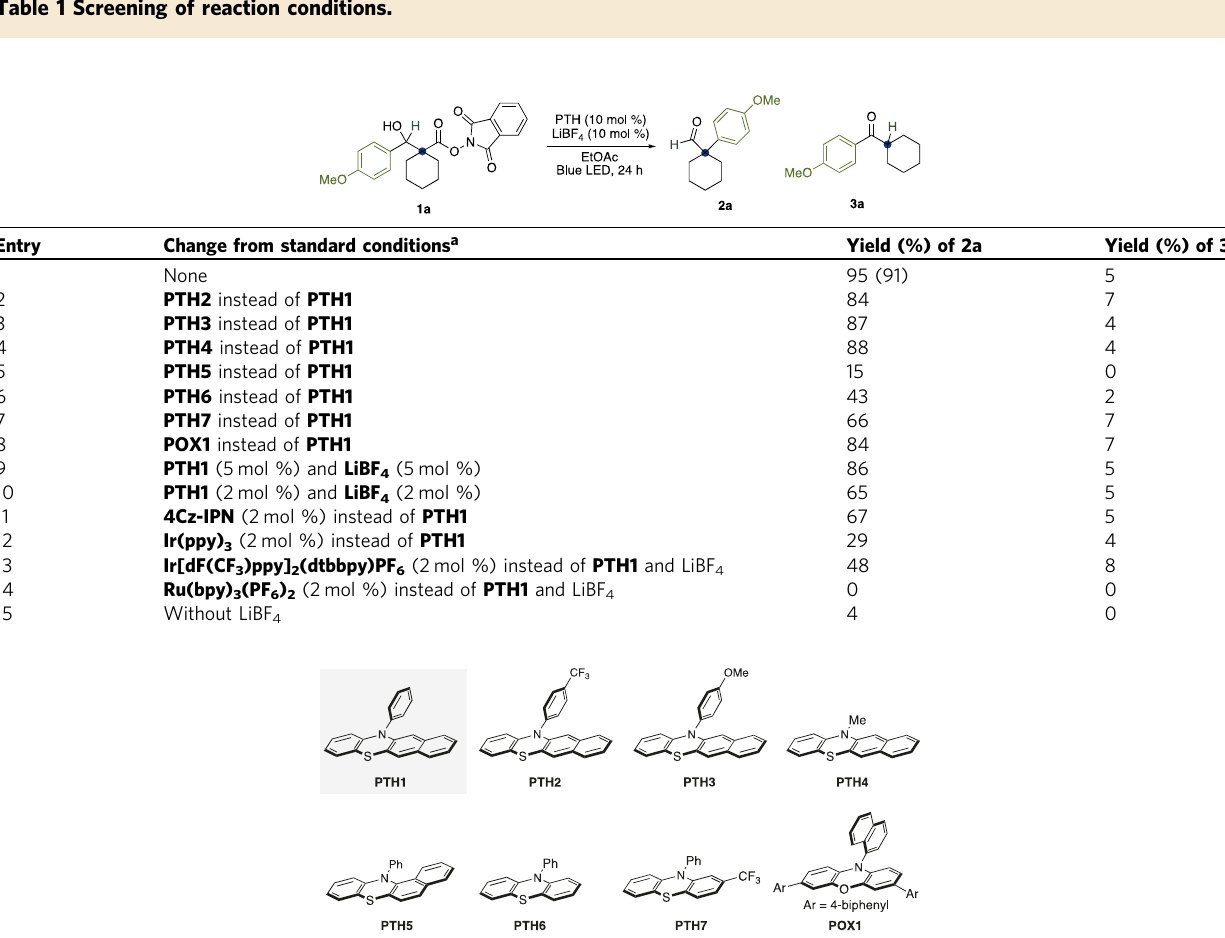
Table 1 Screening of reaction